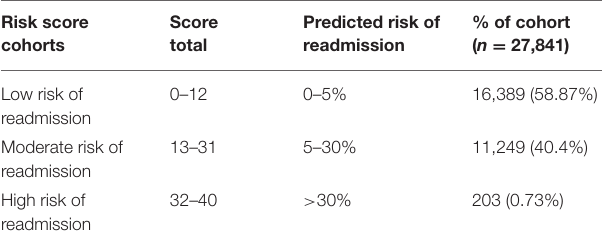
TABLE 3 | Predicted readmission rate by risk-cohort (over all).